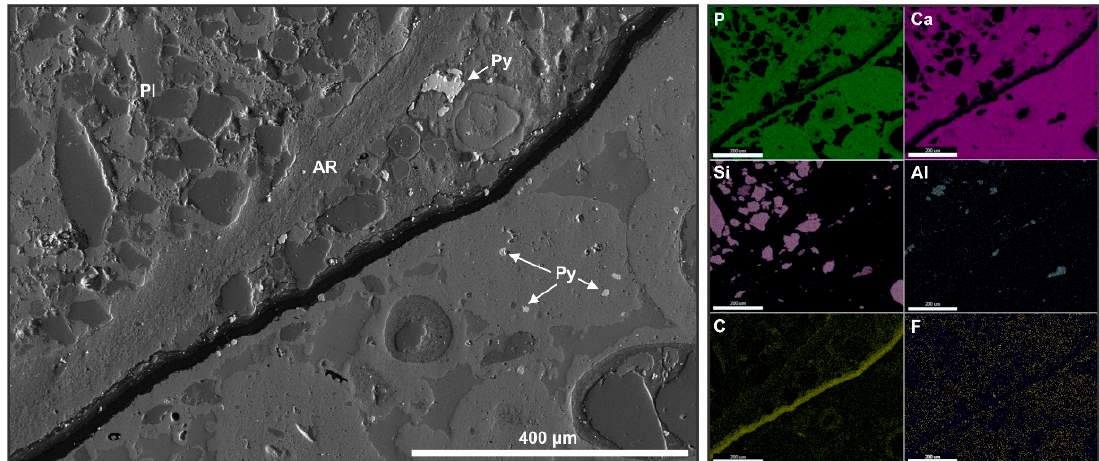
Figure 11. Detailed SEM image of sample MH6 centered on the contact of a phosphatic intraclast (PI) and the rock matrix and granular framework, acquired with ET detector BSE mode, and SDD-EDS elemental maps of select major and trace elements. The apatite intraclast includes silt-size aluminosilicates and quartz grains and records multiple episodes of reworking, as shown by the apatite mineralization internal rim (AR) without siliciclastic grains and the later episode of phosphatization and reincorporation of grains. On the outer edge, there is a large euhedral pyrite crystal (Py), as well as multiple smaller diagenetic pyrite crystals disseminated in the matrix. Solid bitumen is concentrated around the edge of the intraclast, but also occurs disseminated in apatite. A trace amount of fluorine is mapped in association with the apatite, suggesting fluorapatite.